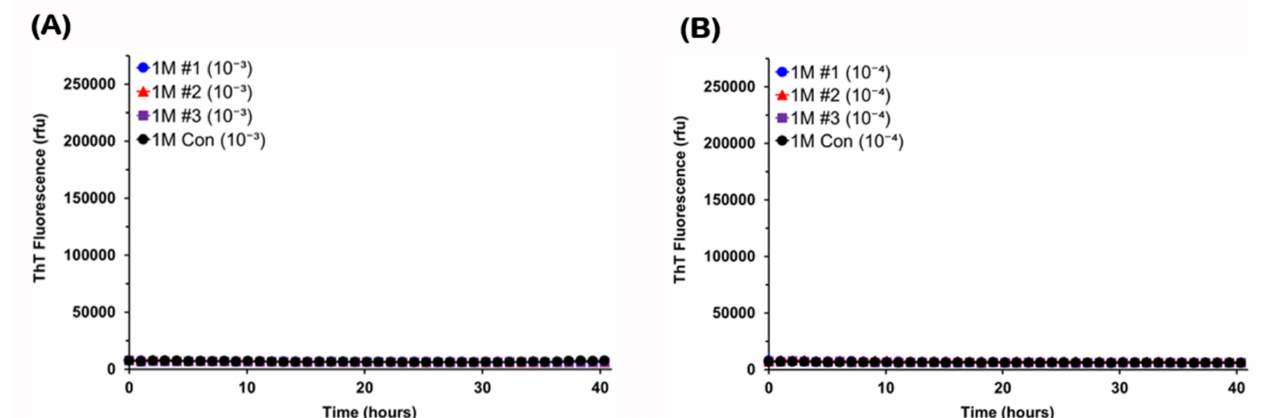
Figure 4. Alpha-synuclein seeding activity is absent in the colon of 1-month-old G2-3 mice. Colon homogenates were prepared from three G2-3 mice of 1 month of age and one non-carrier mouse of the same age. Colon homogenates at 10 − 3 dilution ( A ) or 10 − 4 dilution ( B ) were used to seed RT-QuIC reactions with A53T recombinant α -syn as substrate. ThT fluorescence was measured at one-hour intervals and average values from quadruplicate wells were plotted as a function of time. Table 1. Summary of the α -syn RT-QuIC assay for brains and colons of G2-3 mice. Age at